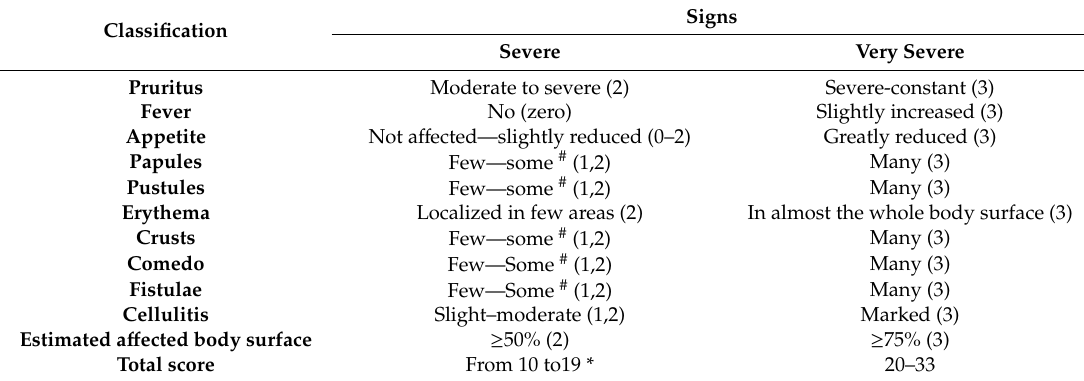
Table 2. Scoring system to classify unresponsive canine deep-pyoderma as severe or very severe, based on clinical signs (as zero, 1, 2, or